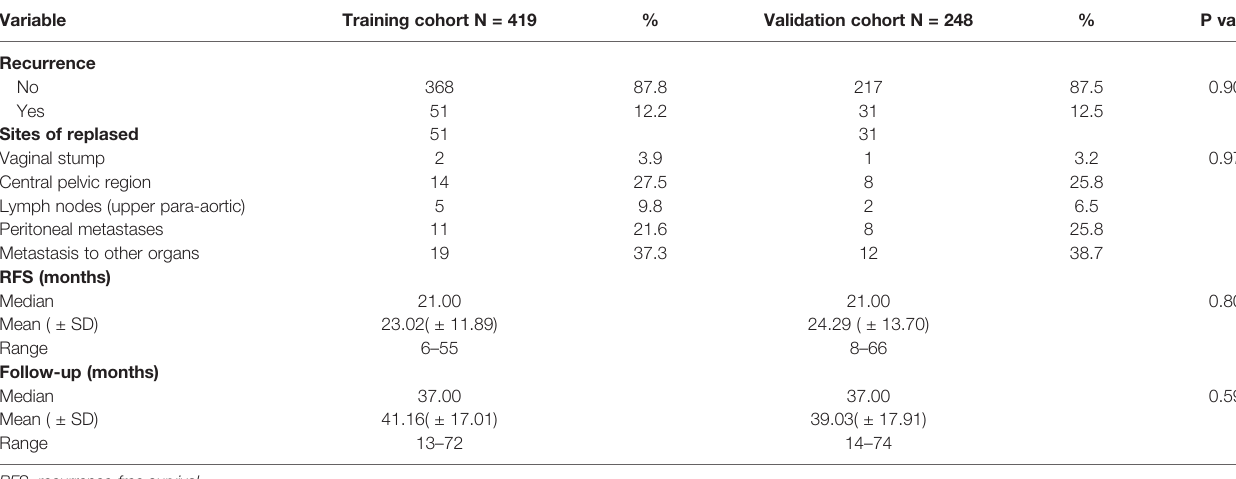
TABLE 2 | Recurrence characteristics and follow-up.